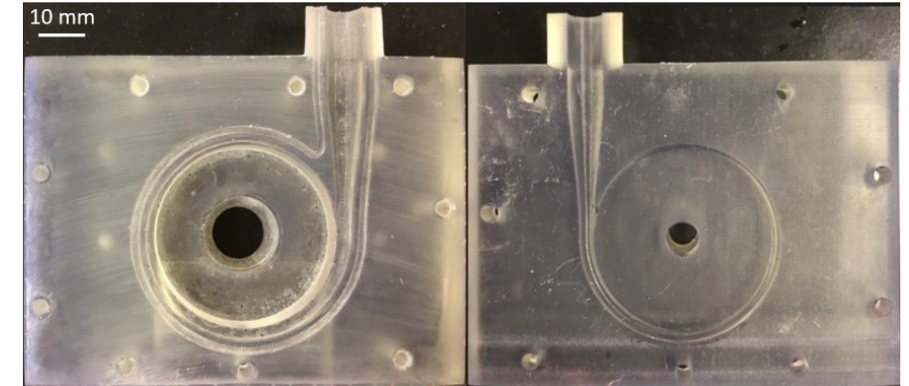
Figure 3. The volute printed by SLA.